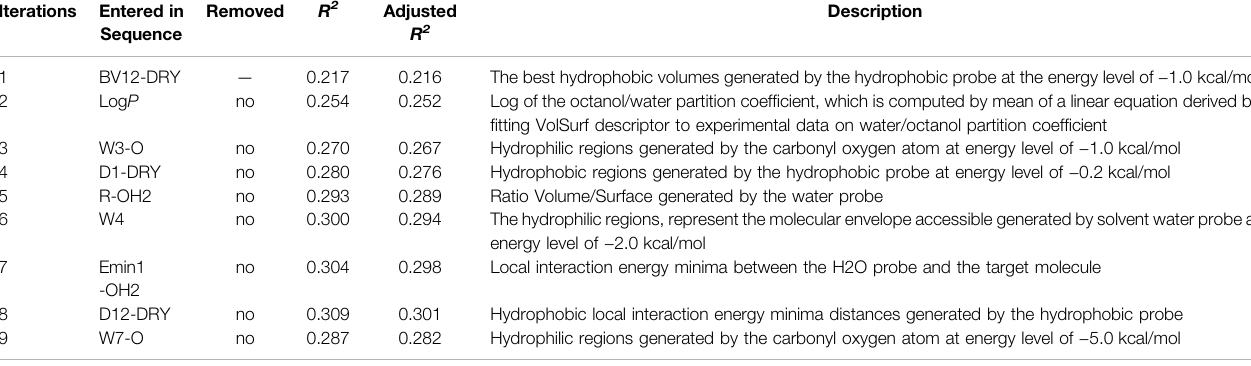
TABLE 1 | Details of feature selection by stepwise linear regression on Volsurf descriptors. Iterations Entered in Removed Sequence